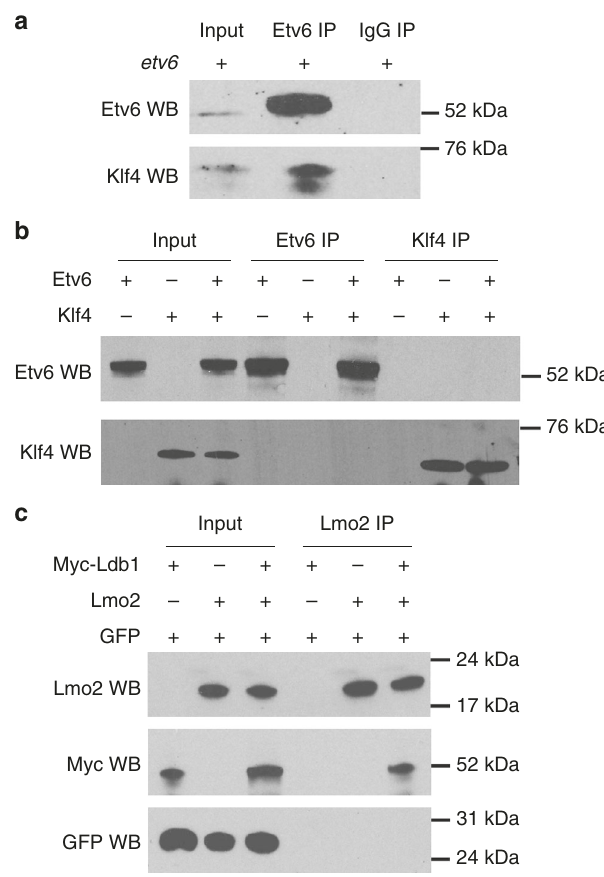
Fig. 6 Etv6 and Klf4 interact indirectly with each other. a In vivo immunoprecipitation assay showing the interaction between Etv6 and Klf4. Protein extracts from the somites of stage 22 embryos overexpressing etv6 mRNA were used for immunoprecipitation. Input lane: somite extracts from embryos injected with exogenous etv6 mRNA; IgG immunoprecipitation: negative control. b In vitro immunoprecipitation assay showing that Etv6 and Klf4 do not directly interact. The Etv6 and Klf4 proteins were synthetized from mRNA using the in vitro rabbit reticulocyte lysate translation system, extracted and used in immunoprecipitation assays with Etv6 antibodies (Etv6 IP) or Klf4 antibodies (Klf4 IP). c In vitro immunoprecipitation assay between two proteins known to physically interact with each other, Lmo2 and Ldb1, was performed as in ( b ) with Lmo2 antibodies (Lmo2 IP). The GFP protein serves as a negative